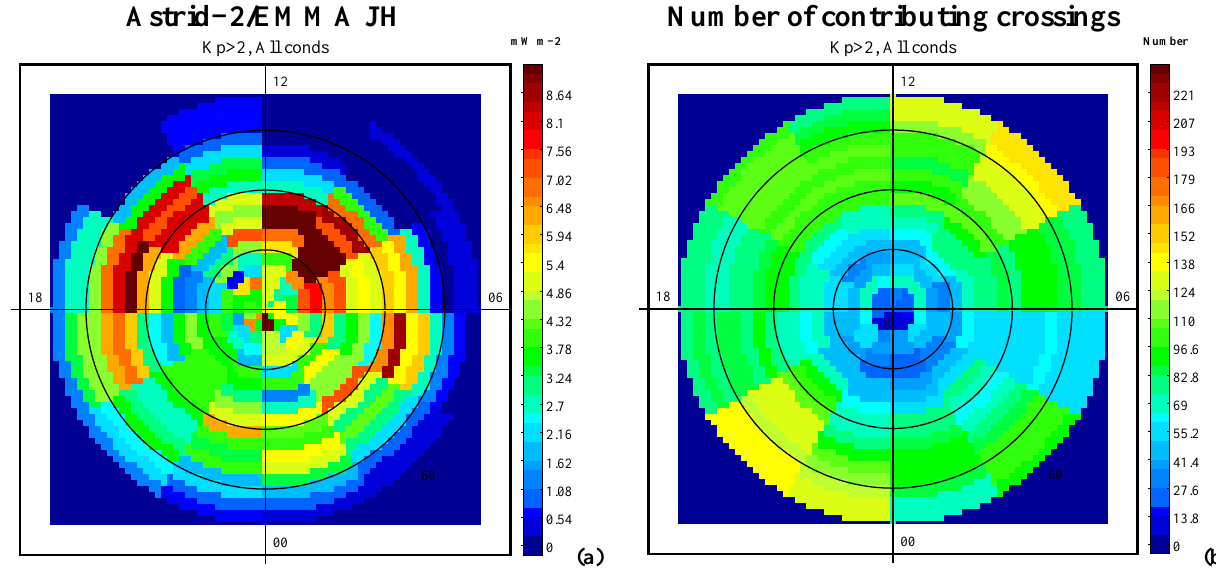
Fig. 3. Same as Fig. 2 but for K p > 2. The average Joule heating is overall higher, often by a factor of 2 and is more significant in wider ILAT